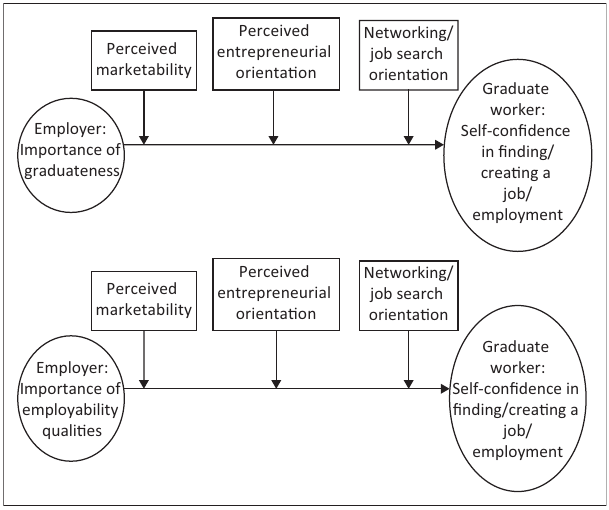
FIGURE 1: Conceptual model of the research: Interaction effects of predictors of graduate workers’ self-confidence in finding or creating a job or